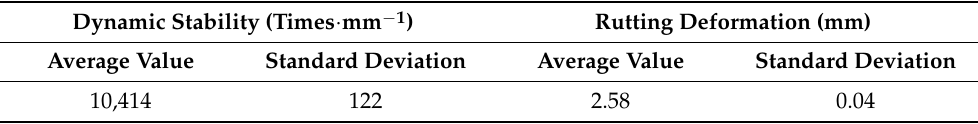
Table 8. Dynamic stability of ASP slab specimens.